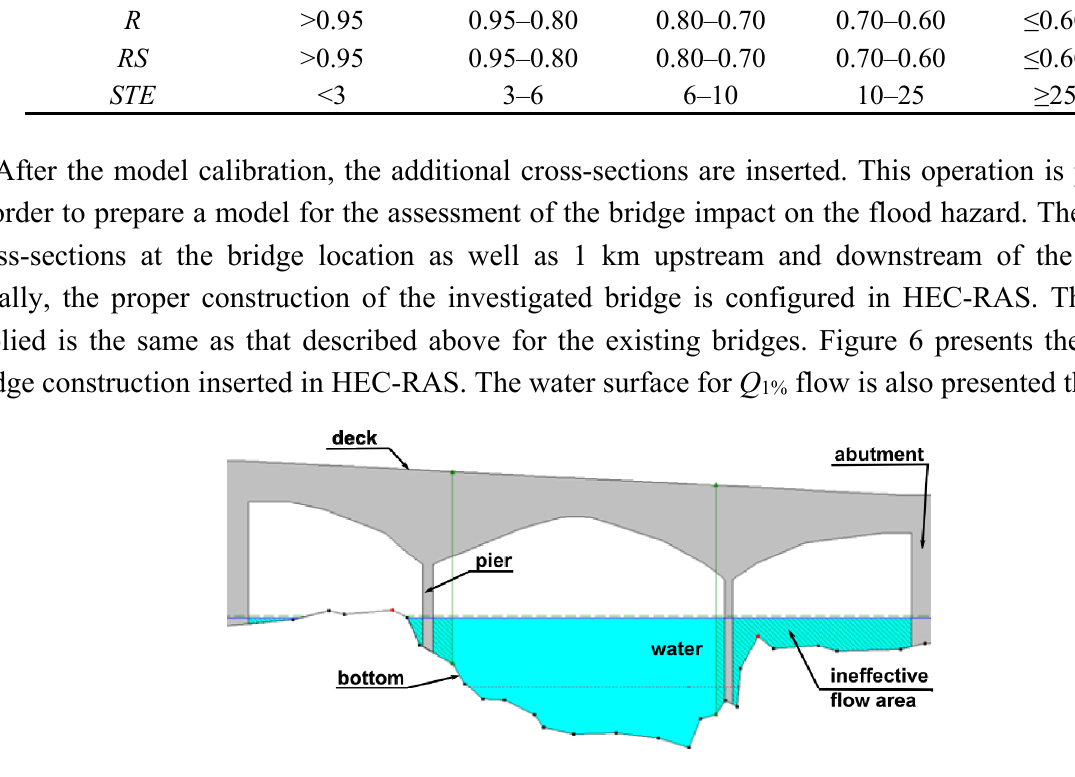
Figure 6. HEC-RAS representation of the designed bridge located at km 172 +